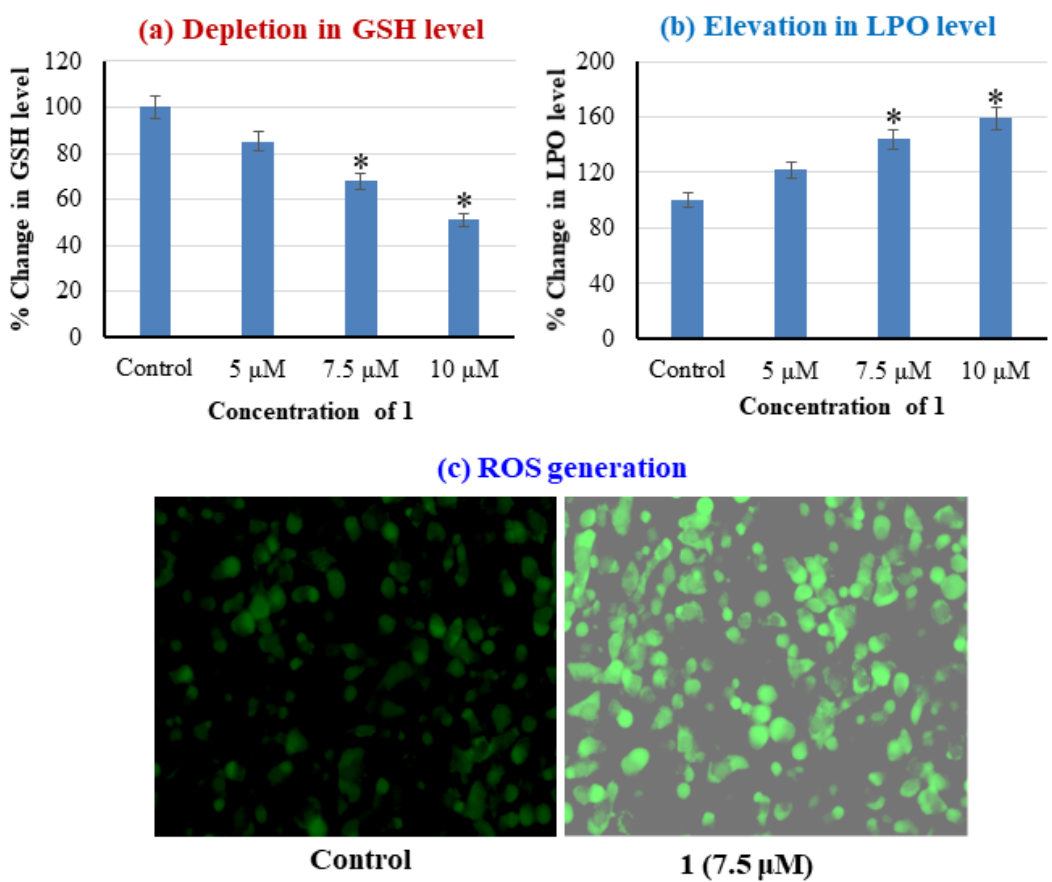
Figure 5. ( a ) Glutathione level in MCF7 cell line after the exposure of complex 1 for 24 h at 5, 7.5, and 10 µ M concentrations. ( b ) Induction in LPO level in MCF7 cell line after the exposure of complex 1 for 24 h at 5, 7.5, and 10 µ M concentrations. ( c ) ROS generation in MCF7 cells exposed to complex 1 for 24 h at 7.5 µ M concentration. * indicates statistically different from the control.